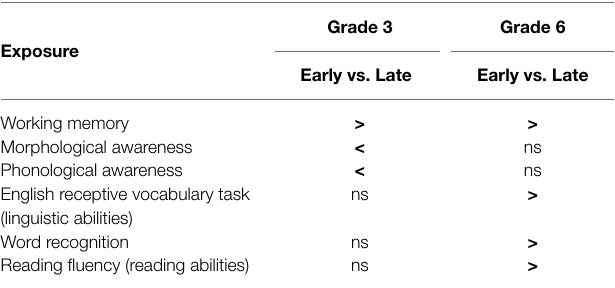
TABLE 9 | Summary of the major